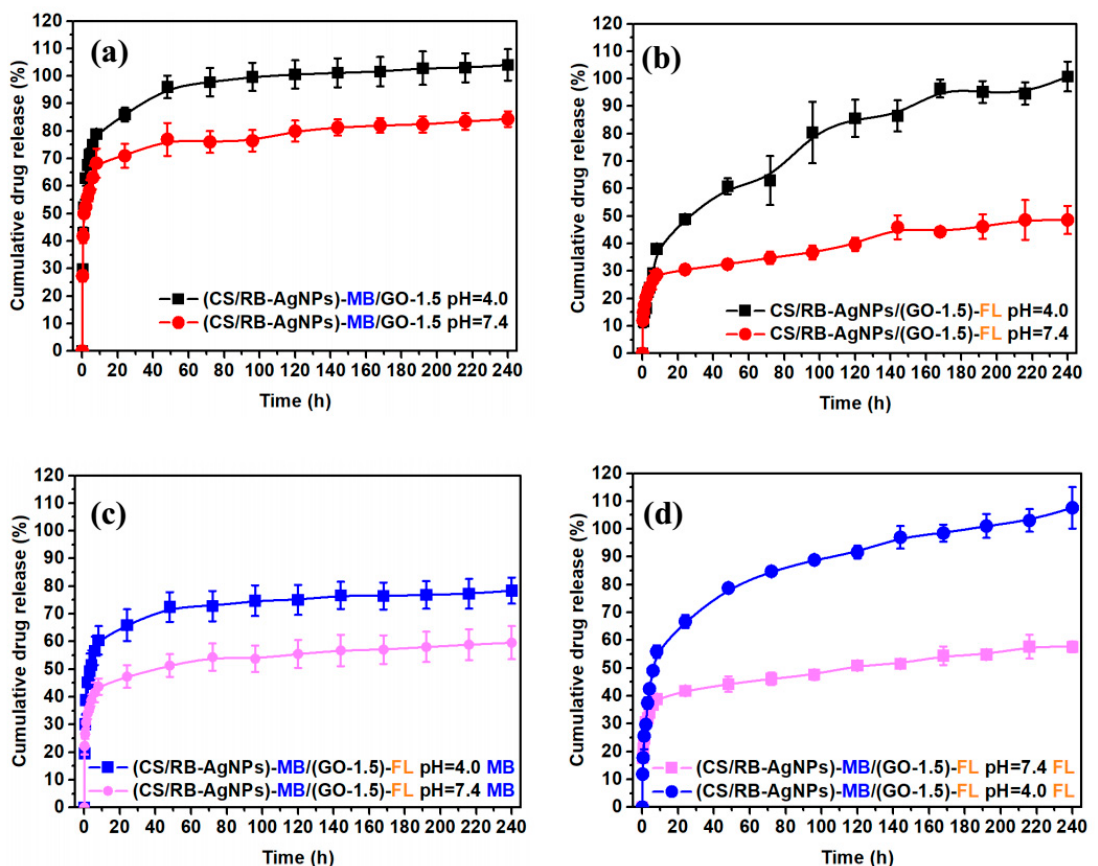
Figure 5. ( a ) Single drug release profile of MB, ( b ) single drug release profile of FL, ( c ) dual drug release profile of MB, and ( d ) dual drug release profile of FL from CS/RB-AgNPs/GO − 1.5.